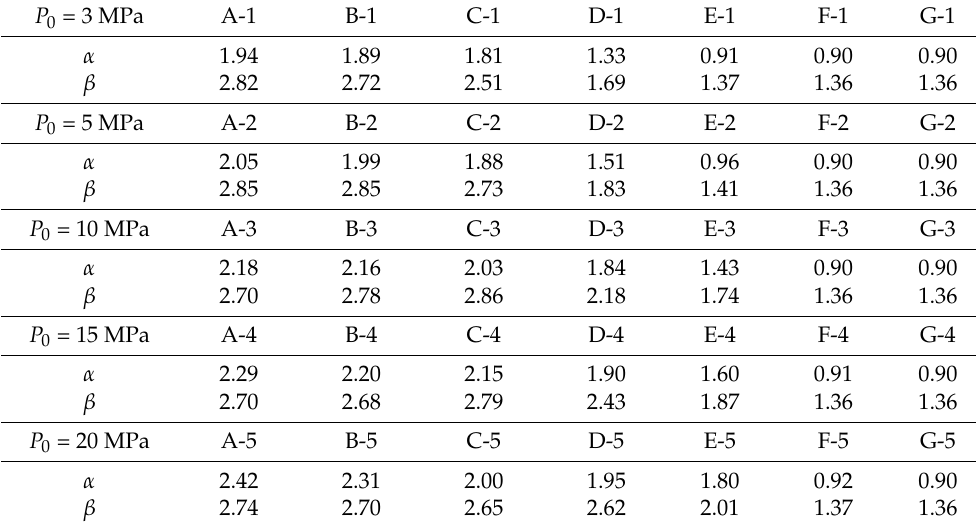
Table 2. Regression analysis results for α and β